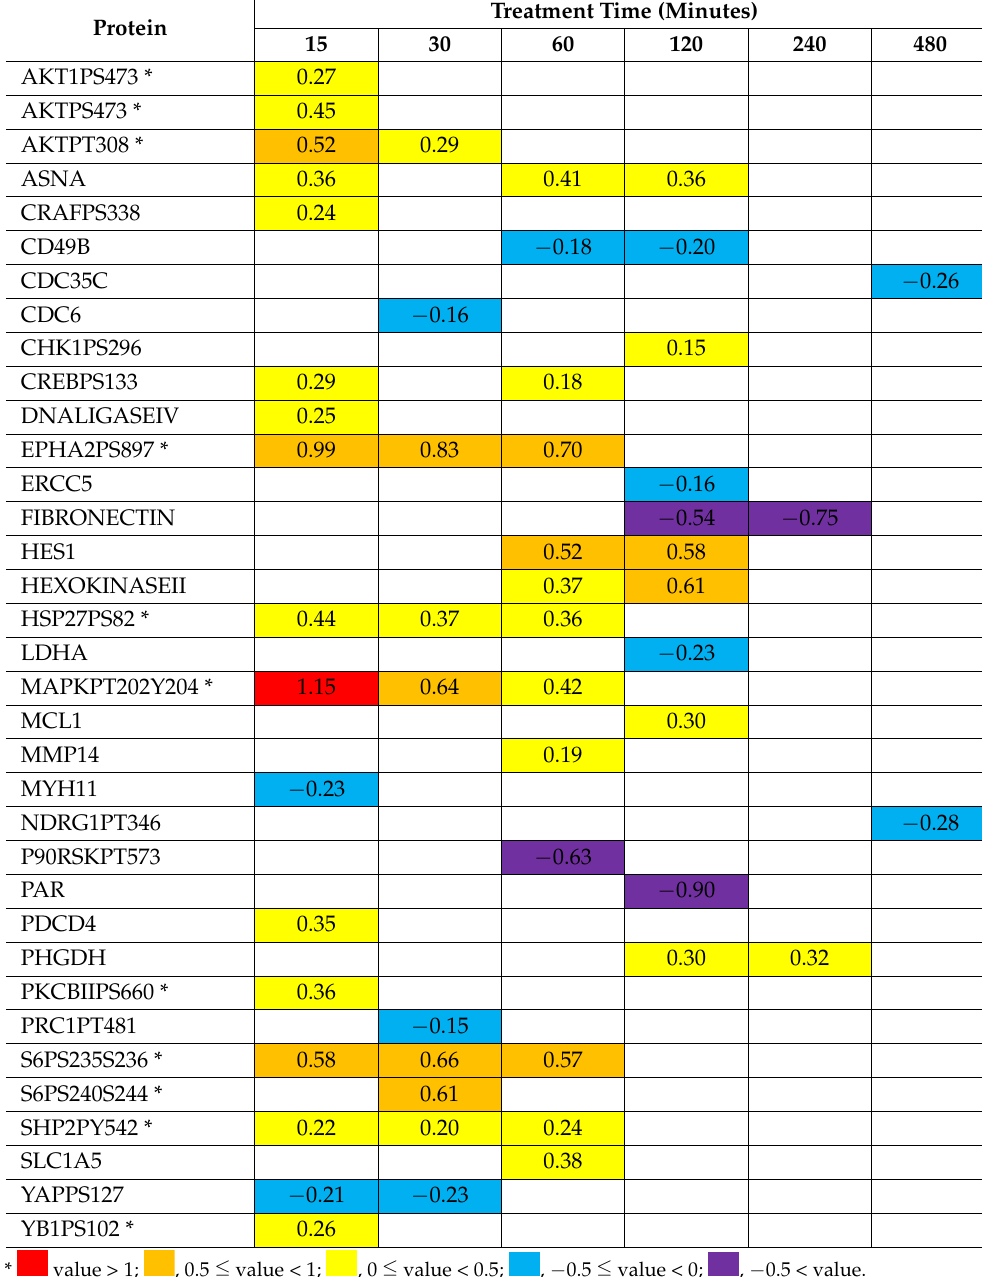
Protein Table 1. Fold changes (log2) of significant (FDR < 0.05) proteins in the cells exposed to S µ G compared to the control cells cultured at 1G. (The extent of changes is color-coded).